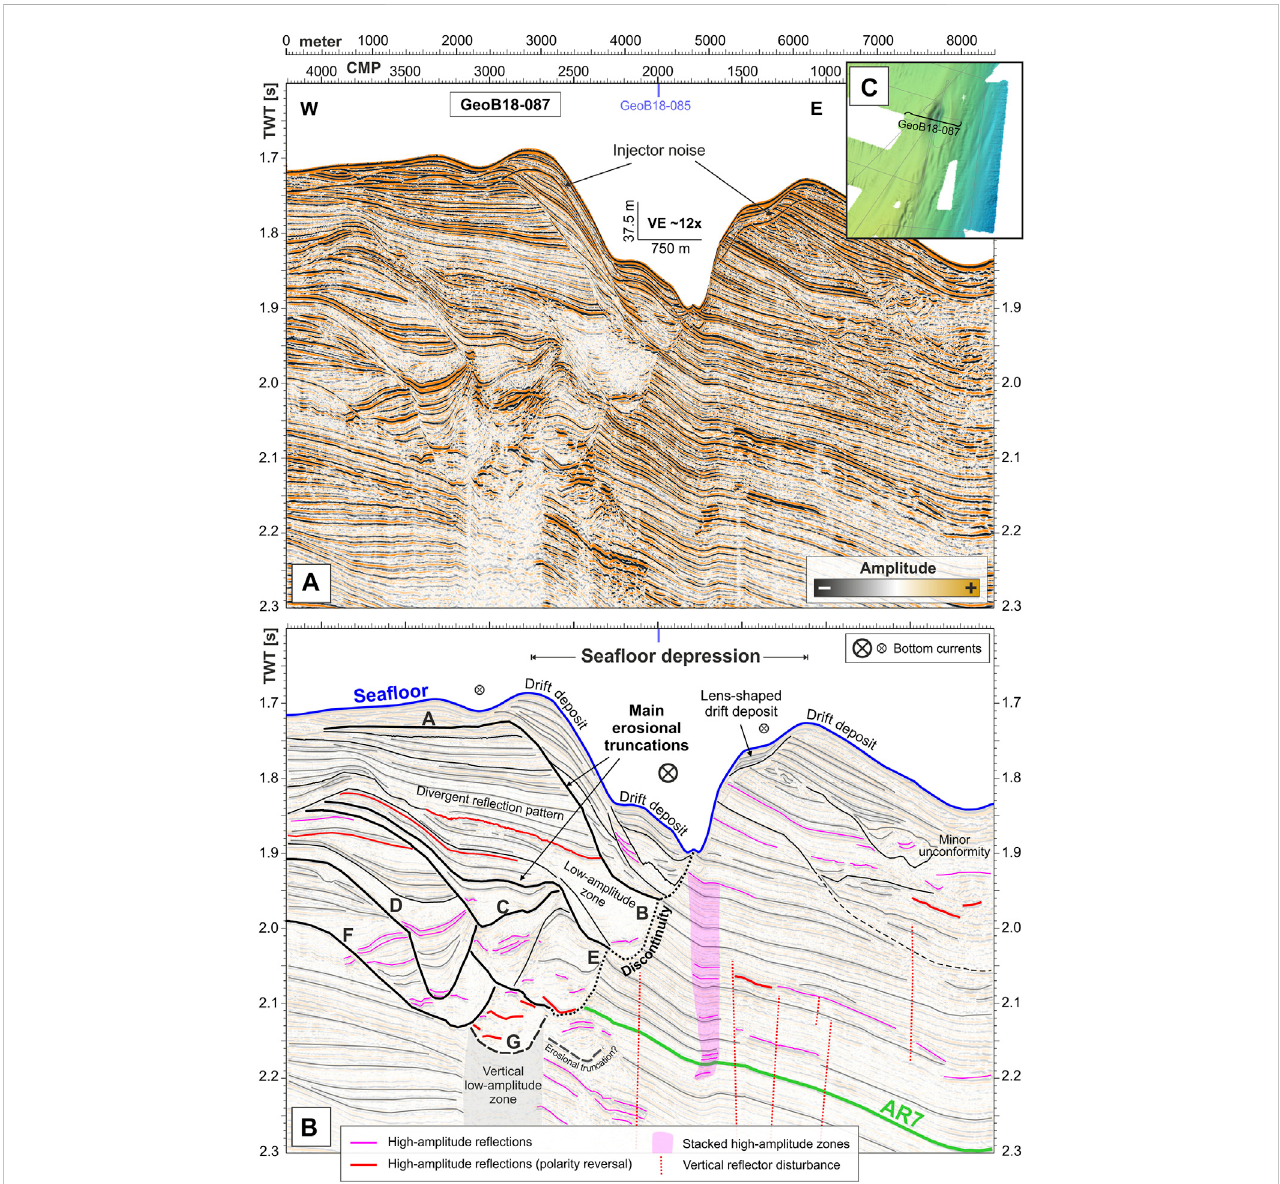
FIGURE 9 Seismic pro fi leGeoB18-087 as (A) migrated sectionand (B) interpreted linedrawingshowing stacked cut-and- fi llstructures(truncationsA-G) and more recent drift deposits inside and at the margins of SD-S. Interpretations of stratigraphic horizon AR7 are based on Gruetzner et al. (2016) (cf. Section 2.3). Prominent discontinuities produced by cut-and- fi ll structures extend the eastern fl ank of the sea fl oor depression into the subsurface (dotted lines). Different amplitude anomalies like high amplitude patterns, re fl ections with reversed sea fl oor polarity, low amplitude zones, and narrow vertical zones of disturbed re fl ections indicate the presence of gas and potential fl uid migration. (C) Bathymetry map showing pro fi le